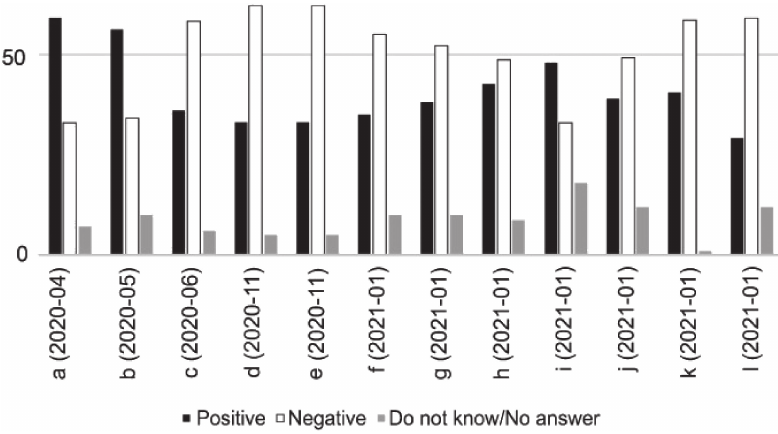
Figure 1. Responses to questions on introducing penalties for non-cooperation with stay-at-home requests Note: The values are in percentages (%). The abbreviations concerning the questions of the opinion polls and their timing of implementations are as follows: “ a ” (Yomiuri-NNN, April 2020), “ b ” (TBS-JNN, May 2020), “ c ” (Yomiuri-NNN,